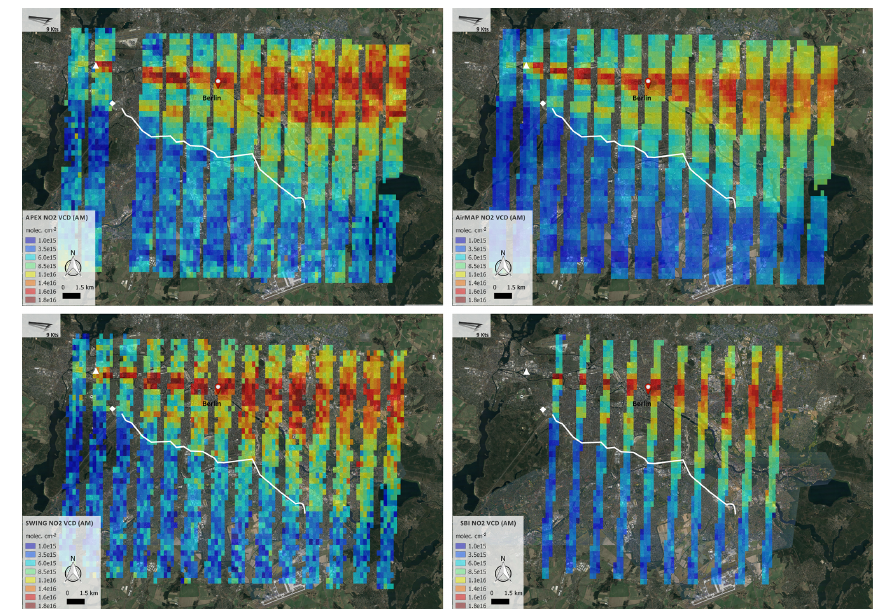
Figure 16. Tropospheric NO 2 VCD maps retrieved from APEX, AirMAP, SWING, and SBI for the morning flight over Berlin on 21 April 2016 (Google, TerraMetrics). For the pixel-wise comparison, discussed in Sect. 7, all NO 2 maps were harmonised to ensure comparability and gridded to the same regular grid size of 0.0045 ◦ . Only the central half of the swath has been compared for APEX, AirMAP, and SWING, corresponding to a swath of roughly 1500m. The key contributing NO 2 emission sources are indicated by a white triangle (power plant Reuter West) and white diamond (Messe Berlin). The highways A100 and A113, running south of the city, are marked by the white line. Hourly averaged wind vectors indicate the surface wind at 08:00 (light grey, 3.3ms − 1 ), 09:00 (grey, 4.9ms − 1 ), and 10:00 (black, 5.1ms − 1 ) UTC. The average surface wind speed is indicated on the